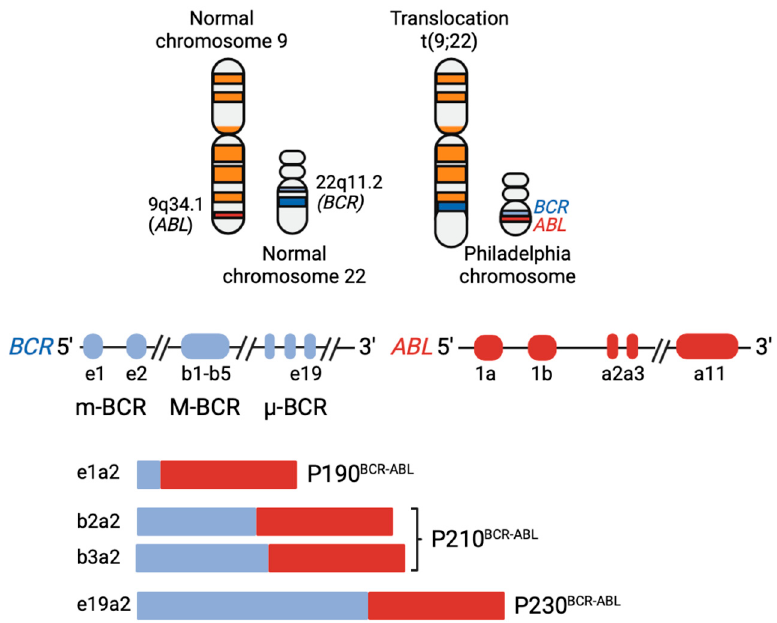
Figure 1. Representation of the Philadelphia chromosome translocation and BCR-ABL chimeric proteins. (Top) Translocation (9;22) and derivative Philadelphia-chromosome. (Bottom) BCR and ABL genes breakpoints and resulting fusion transcripts. BCR presents three breakpoints clusters: m-BCR, most associated to B-ALL; M-BCR, associated to CML; and µ-BCR, associated to chronic neutrophilic leukemia. ABL gene breakpoints usually occurs in between the first two exons (e1, e2), resulting in fusion proteins retaining the active tyrosine kinase domain of the ABL gene and different portions of the BCR gene. Image created with BioRender.com (2020).